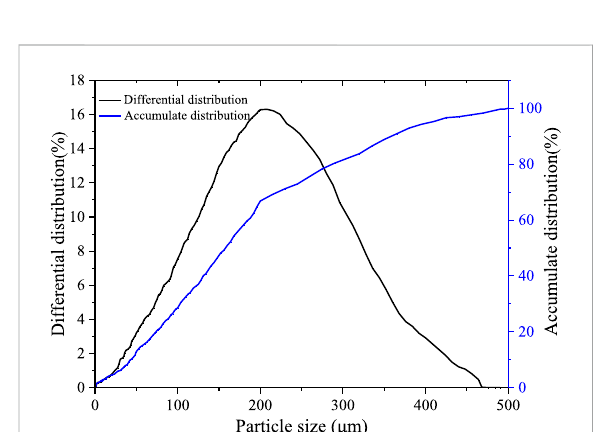
FIGURE 2 Particle size distribution diagram of the tailings.